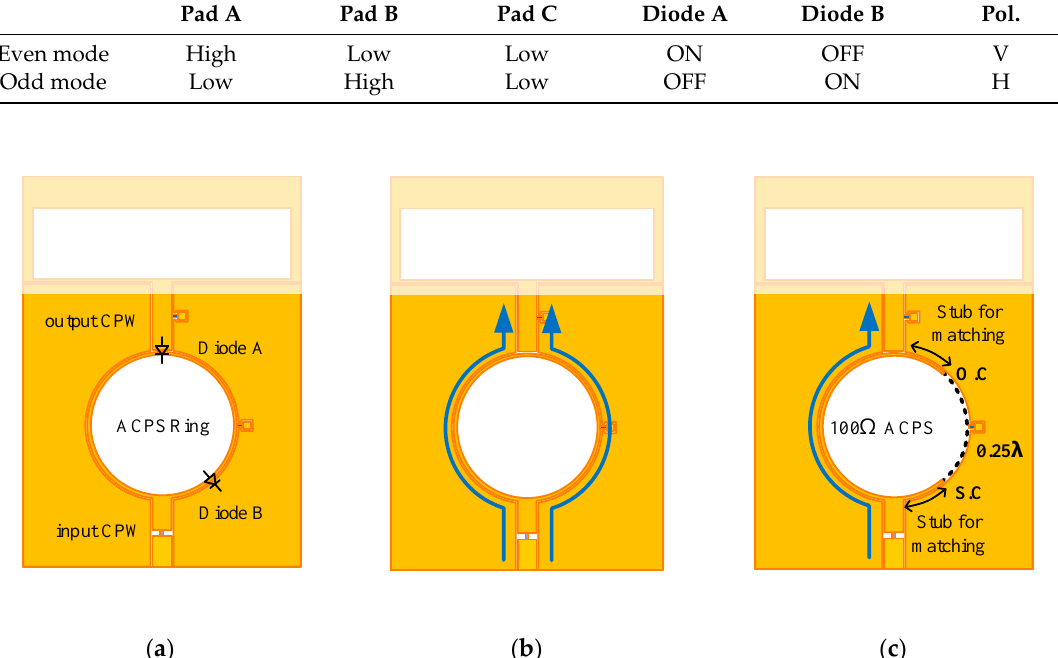
Figure 3. ACPS switching ring circuit: ( a ) position and polarity of the diodes; ( b ) even mode current flow; and ( c ) odd mode current flow.